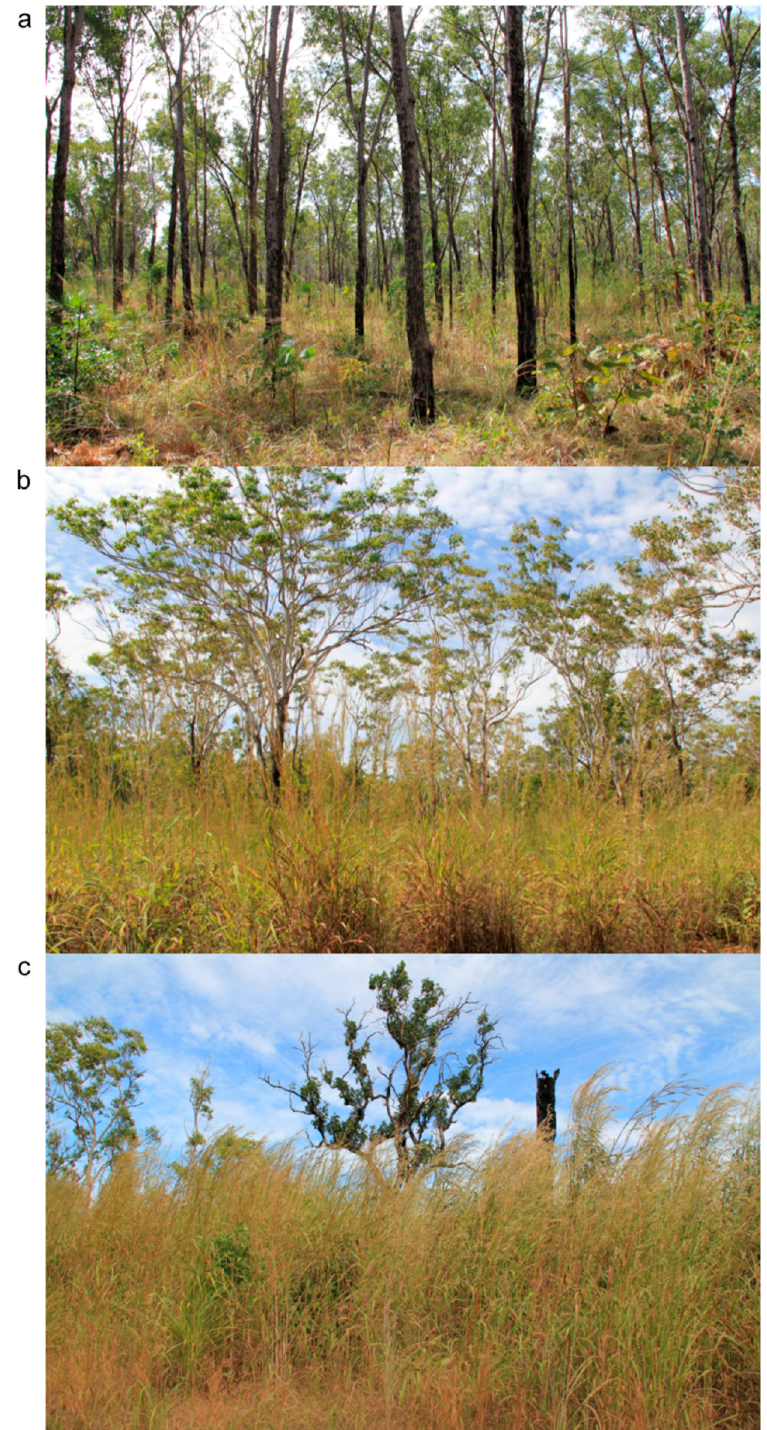
Figure 1. Typical vegetation structure in three stages of invasion—( a ) a native vegetation site; ( b ) a site at the early stage of invasion with A. gayanus in understory and an intact Eucalyptus dominated overstory; and ( c ) a site heavily invaded with A. gayanus with a decline in overstory trees due to high intensity